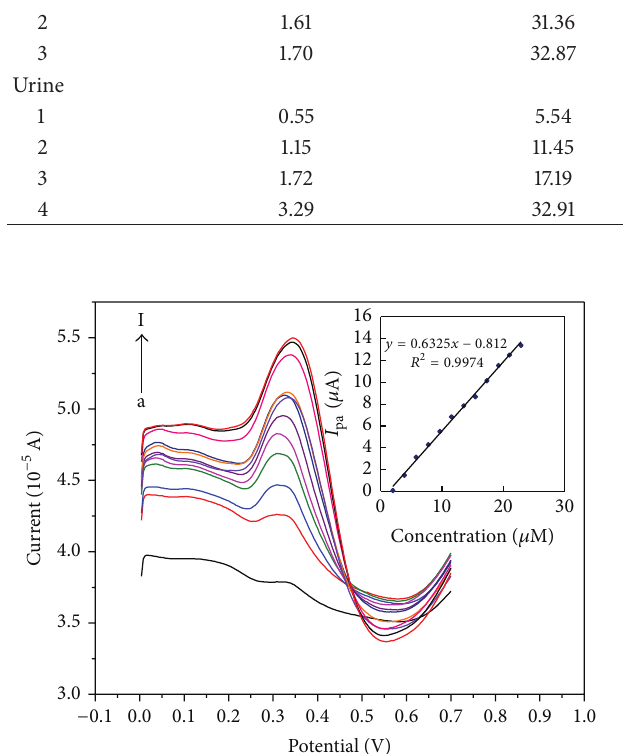
Figure 9: DPVs of FA with different concentrations (a: 0.0895; b: solution. Conditions: scanned from 0 V to 0.7 V with amplitude of 0.05 V and pulse width of 0.05 s. Inset: the calibration curve between the anodic peak currents with the concentration of